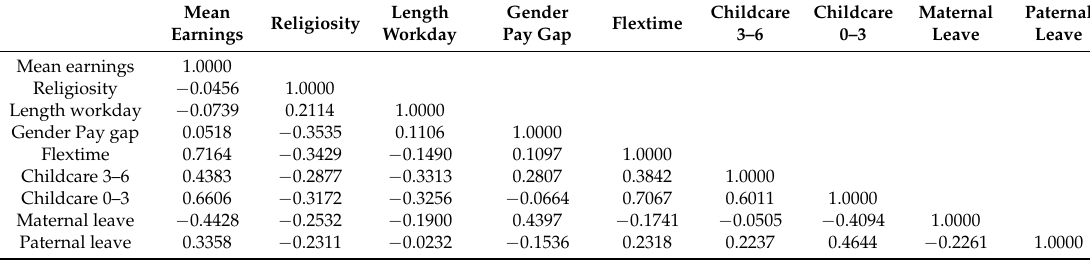
Table A5. Correlation matrix macro-level